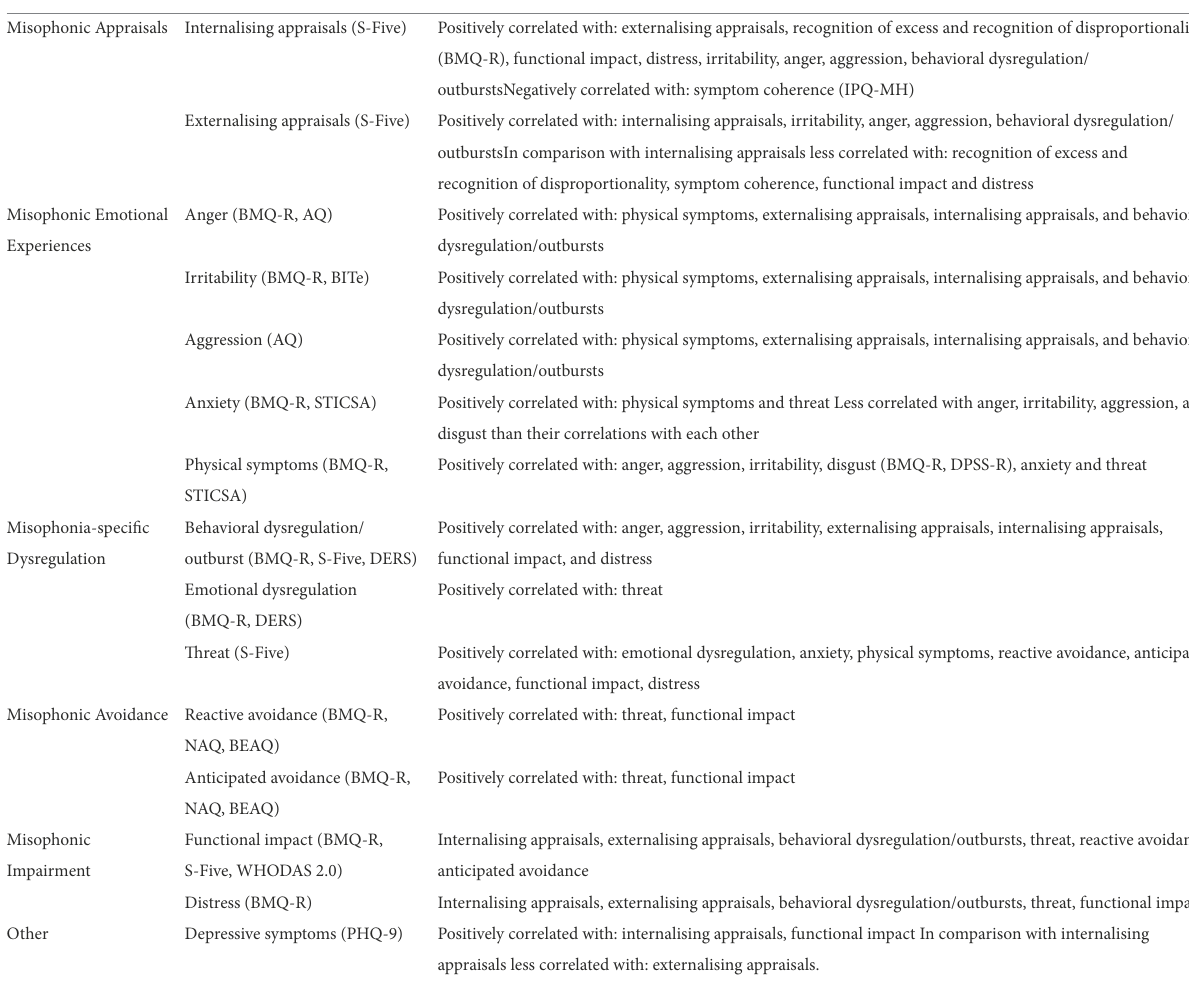
TABLE 2 Predicted Associations between Misophonic Symptoms in the Nomological Network. Symptom